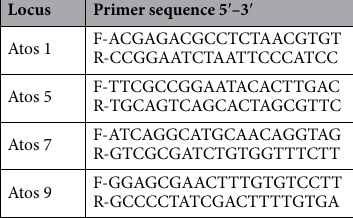
Table 2. Microsatellite loci and specific primer sequences chosen from Miller et al. 46 (for this study, fluorescent M13 tails were added to original F-primers). Only four out of nine markers fit the genomes of mites from our experimental populations, probably due to the great geographical distance between Australia and